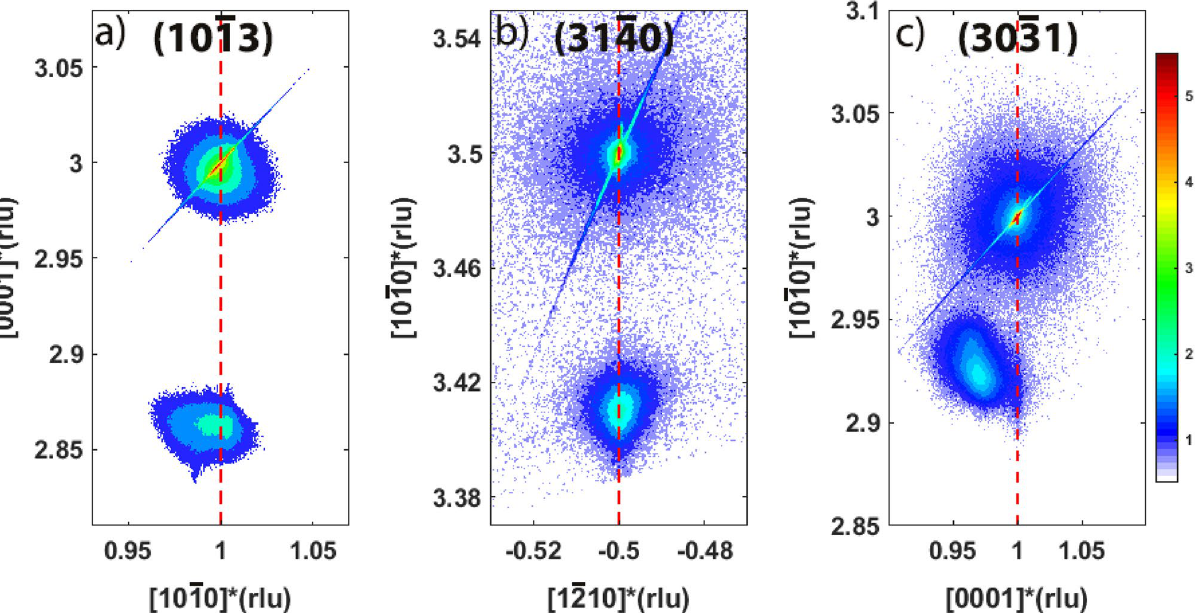
Figure 1. Reciprocal Space Maps (RSMs) around ( a ) the ( 10 ¯ 13 ) Bragg peak, of a Z-cut quartz substrate ([0001] out-of-plane), showing the epitaxially grown GeO 2 film; ( b ) the ( 31 ¯ 40 ) Bragg peak and ( c ) ( 30 ¯ 31 ) Bragg peak of a Y-cut quartz substrate ( [ 10 ¯ 10 ] out-of-plane), showing that the GeO 2 film is coherently grown (strained) along the [ 1 ¯ 210 ] direction and relaxed along the [0001] direction. The color bar represents the x-ray intensity (log. scale) in counts per